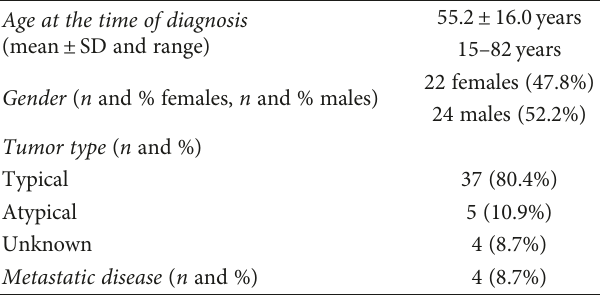
Table 1: Characteristics of bronchial NET patients diagnosed, treated, or followed-up at our institution from 1 st January 1995 to 31 st December 2015 ( n = 46 ).